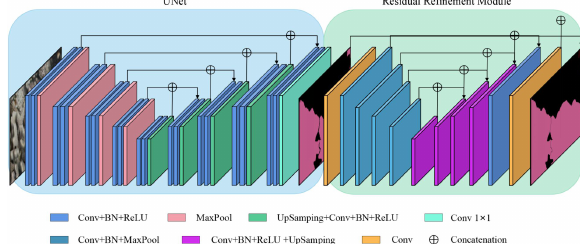
Figure 6 . Architecture of our semantic segmentation network: the combination of U-Net and residual refinement module.